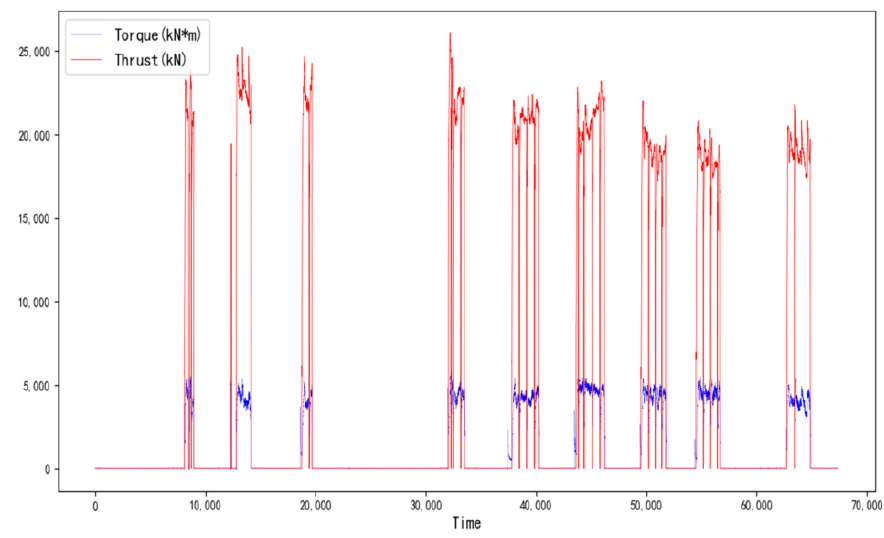
Figure 2. Torque and thrust in the raw data from